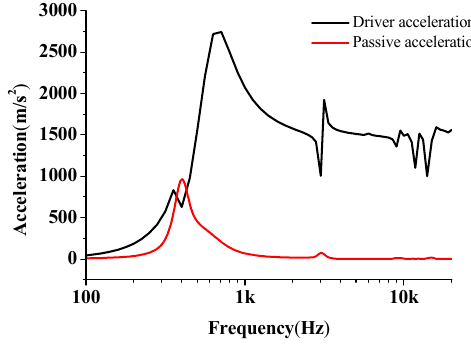
Figure 10. Acceleration of driver and passive radiator.